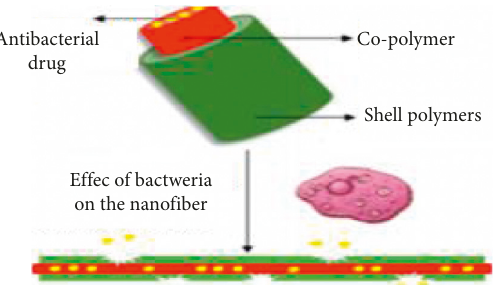
Figure 6: Bacterial responsive core-shell nanofiber